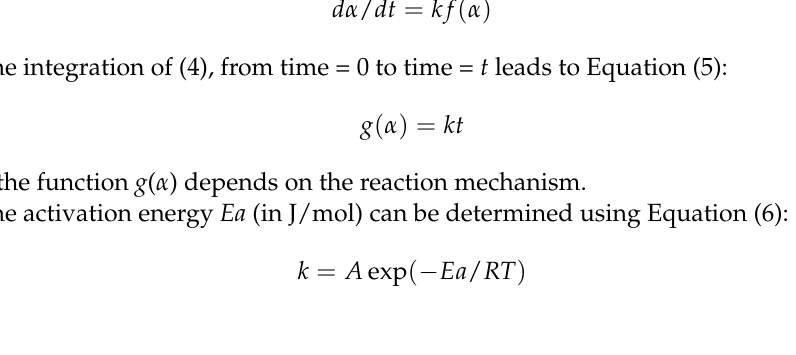
Figure 4. Schematic for the structure of the smectite mineral and two layers of water molecules in the interlayer spacing. Here, T and O denote the silicon tetrahedral sheet and alumina octahedral sheet, respectively. Cation denotes the cation ion sorption on the